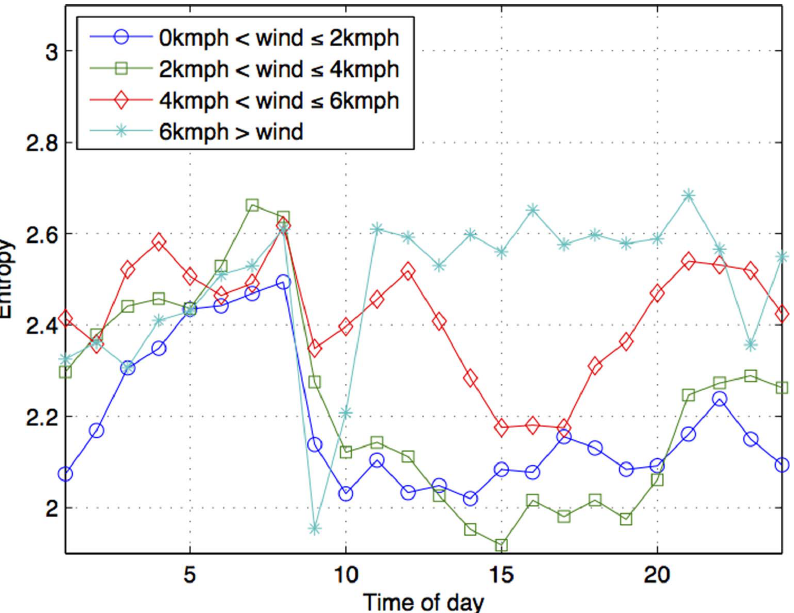
Figure 14. Entropy values across time of the day under different bands of windspeed.